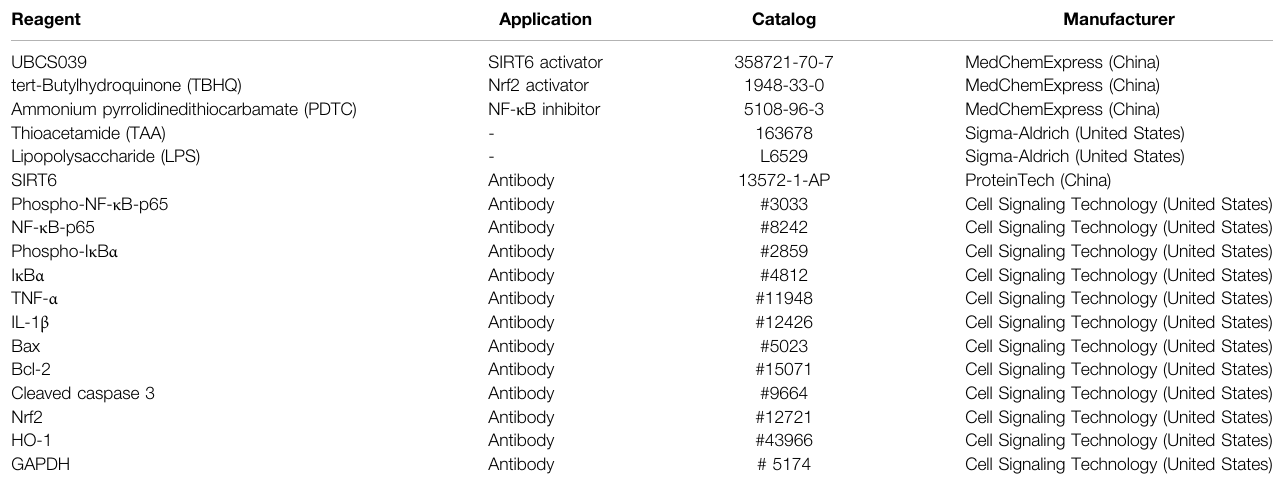
TABLE 1 | List of chemicals and